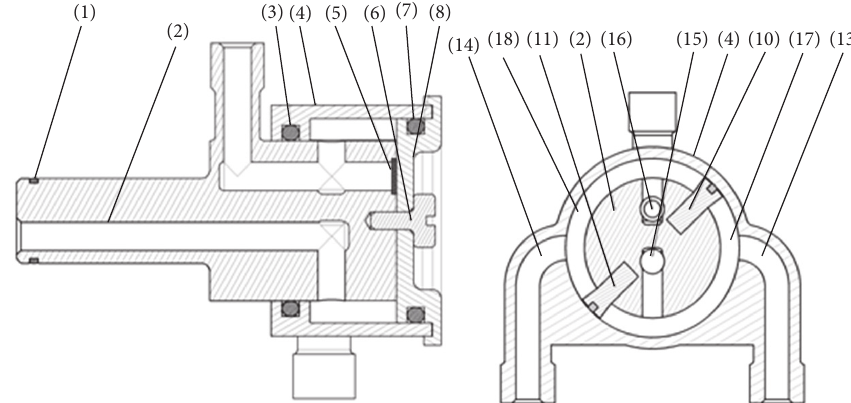
Figure 3: Profile of the following swivel reversal valve. (1) The first seal ring, (2) swivel valve core, (3) the second seal ring, (4) pressure hull, (5) gasket, (6) blot, (7) the third seal ring, (8) cover, (10) the first partial chamber bond, (11) the second partial chamber bond, (13) the first supply/return hydraulic hole, (14) the second supply/return hydraulic hole, (15) the first hole, (16) the second hole, (17) the first ring chamber, and (18) the second ring chamber.